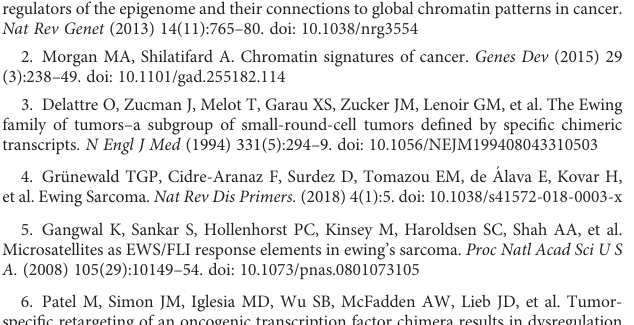
analyses for protein enrichment under standard (150 mM NaCl) and high salt (500 mM NaCl) conditions normalized to Input band intensities quanti fi ed in . Results shown are representative of three technical replicates. SUPPLEMENTARY FIGURE 4 (A) Western blot analyses of EWSR1::FLI1 and hnRNPH1 protein following infection with the indicated sh RNAs in A673-CRISPRi cells for 4 days. Left: Representative western blots. Right: Quanti fi cation of western blot band intensities for EWSR1::FLI1 and hnRNPH1 normalized to Histone H3 band intensities. Results are shown as the fold change of non-speci fi c guide (sh NS) cells. Error bars represent the standard deviation of three biological replicates. (B) EWSR1::FLI1 and hnRNPH1 expression measured by RT-qPCR in A673-CRISPRi cells following infection with the indicated sh RNAs for 4 days. Results are shown as the fold change of non-speci fi c guide (sh NS) cells. Error bars represent the standard deviation of three biological replicates. (C) FAIRE- qPCR at EWSR1::FLI1-bound and control loci in A673-CRISPRi cells infected with the indicated sg and sh RNAs for 4 days. Results are shown as a fraction of input control. Error bars represent the standard deviation of three biological replicates. (D) Cell proliferation curves by live cell imaging for EWS502-CRISPRi cells infected with the indicated sgRNAs for 4 days. Proliferation was assessed byimagescapturedevery2hours.Resultsareshownasthepercentcon fl uence. Error bars represent the standard error of the mean of 25 images taken from one well per condition per time point. (E) FAIRE-qPCR at EWSR1::FLI1-bound loci in EWS502-CRISPRi cells infected with the indicated sgRNAs (Top: sg hnRNPH1, Bottom: sg EWSR1) for 4 days. Results are shown as a fraction of input control. Error bars represent the standard error of two biological replicates. (F) FAIRE-qPCR at positive control loci in A673-CRISPRi cells infected with the indicated sgRNAs (Top: sg hnRNPH1, Bottom: sg EWSR1) for 4 days. Results are shown as a fraction of input control. Error bars represent the standard error of three biological replicates. SUPPLEMENTARY FIGURE 5 (A) Volcano plot of log2 fold change of gene expression in EWS894 cells treated 16 hours with 5 m M MS0621 or vehicle control (DMSO). Colored points represent genes that are both upregulated by EWSR1::FLI1 per Kinsey et al., 2006 and differentially expressed with MS0621 treatment. (B) Enriched Biological Processes GO terms for genes that are both downregulated with MS0621 treatment and upregulated by EWSR1::FLI1. Results shown are the -log 10 adjusted p-value for the top 20 enriched GO terms. (C) Enriched Biological Processes GO terms for all genes downregulated with MS0621 treatment. Results shown are the -log 10 adjusted p-value for the top 20 enriched GO terms. (D) Enriched Biological Processes GO terms for all genes upregulated with MS0621 treatment. Results shown are the -log 10 adjusted p- value for the top 20 enriched GO terms. (E) Enriched Biological Processes GO terms for genes with RI events lost with MS0621 treatment. Results shown are the -log 10 adjusted p-value for enriched GO terms. (F) Enriched Biological Processes GO terms for genes with SE events in NMD-associated transcripts events lost with MS0621 treatment. Results shown are the -log 10 adjusted p- value for enriched GO terms. (G) Signi fi cant differential alternative splicing identi fi ed by rMATS in A673 following EWSR1::FLI1 or control knockdown for 48 hr and meeting the additional criteria: supported by at least 20 reads, Inclusion Level Difference > 10%, and FDR < 0.05. Analyzed data were previously published